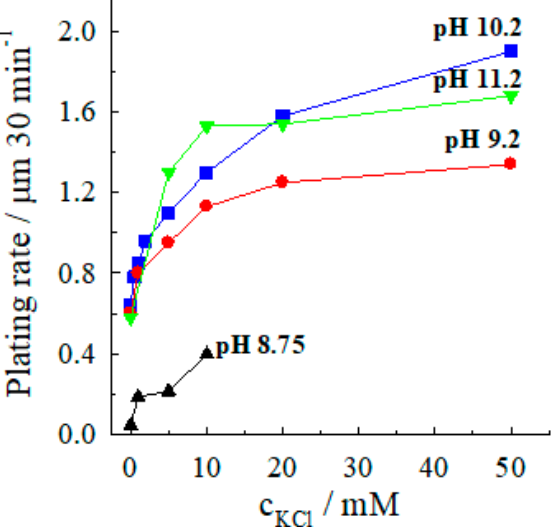
Figure 2. Dependence of the silver deposition rate on the chloride concentration at various pH. Solution composition (M): AgNO 3 —0.04, CoSO 4 —0.10; (NH 3 + NH 4+ )—4; 20 °C.